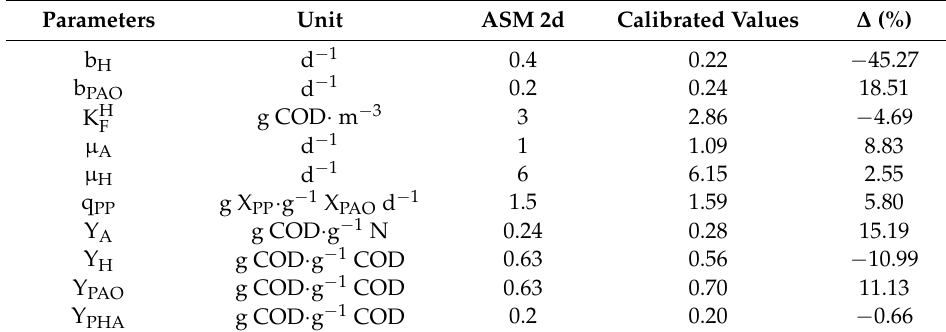
Table 3. Original and calibrated values of the selected parameters in the AS model. Parameters